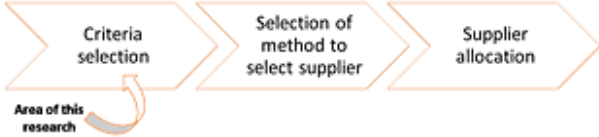
Figure 1. Focus of this survey in the process of supplier